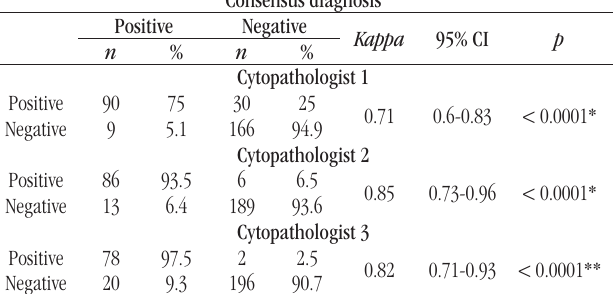
taBLE 3 – Agreement on positive and negative diagnoses among the three cytopathologists, and on consensus of anal cytologies in women with cervical neoplasia Consensus diagnosis